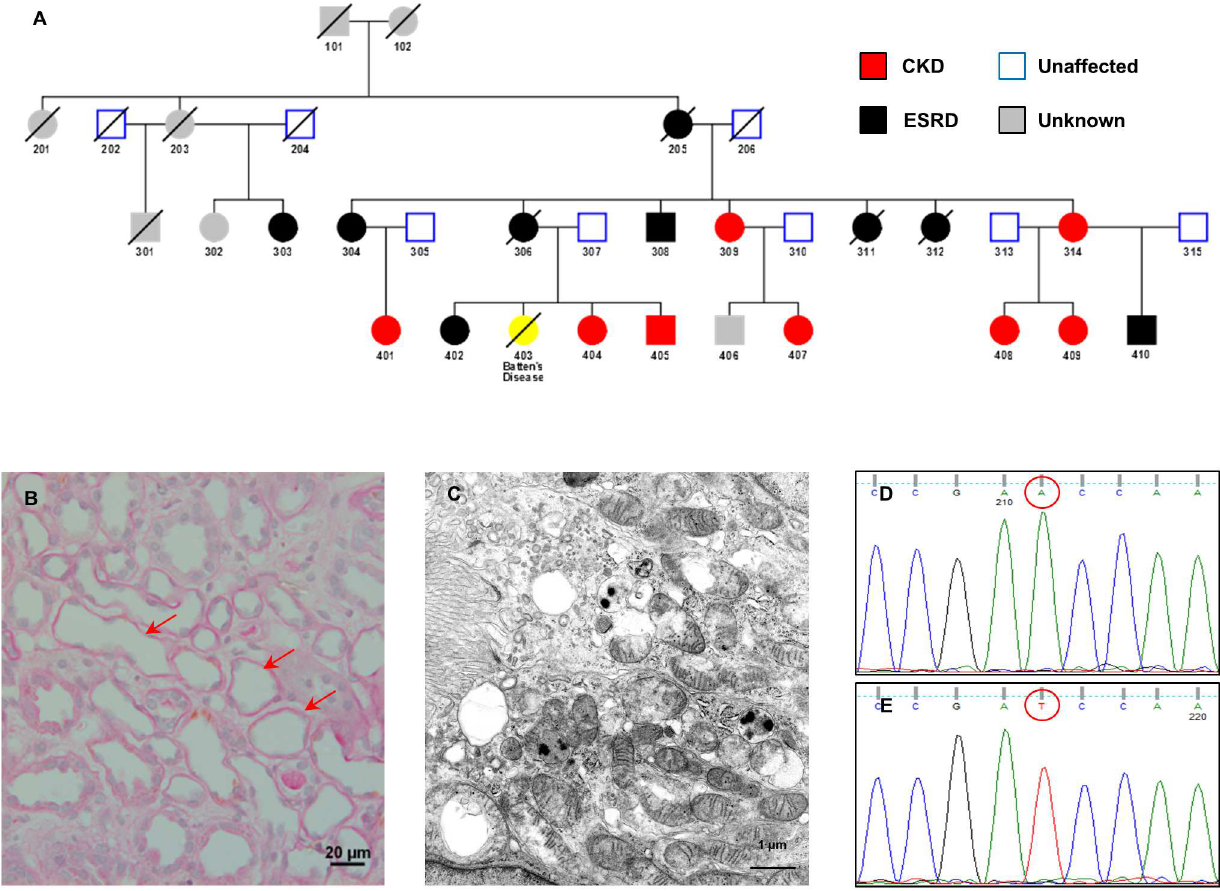
Fig 1. Pedigree with maternally inherited renal disease and m.547A > T substitution. (A) Pedigreeof family showingindividualsaffected with chronic kidney disease(CKD, red symbols), and end-stage renal disease (ESRD, black symbols). One individual(yellowsymbol) died many years previously age 18 with a diagnosis of Batten’s disease basedon electronmicroscopy of a skin biopsy showingcharacteristic curvilinearbodies.We considerthis to be unrelated to the renal disease(B) Renalbiopsy showingevidenceof focal tubular atrophy by light microscopy(arrowed).(C) Renalbiopsy showingmitochondria in a renal tubular epithelialcell which appearstructurally normalon electron microscopy. (D) Sanger sequencing of mtDNA from a control individual. (E) Sequence of an affected individual showingthe homoplasmic m.547A > T